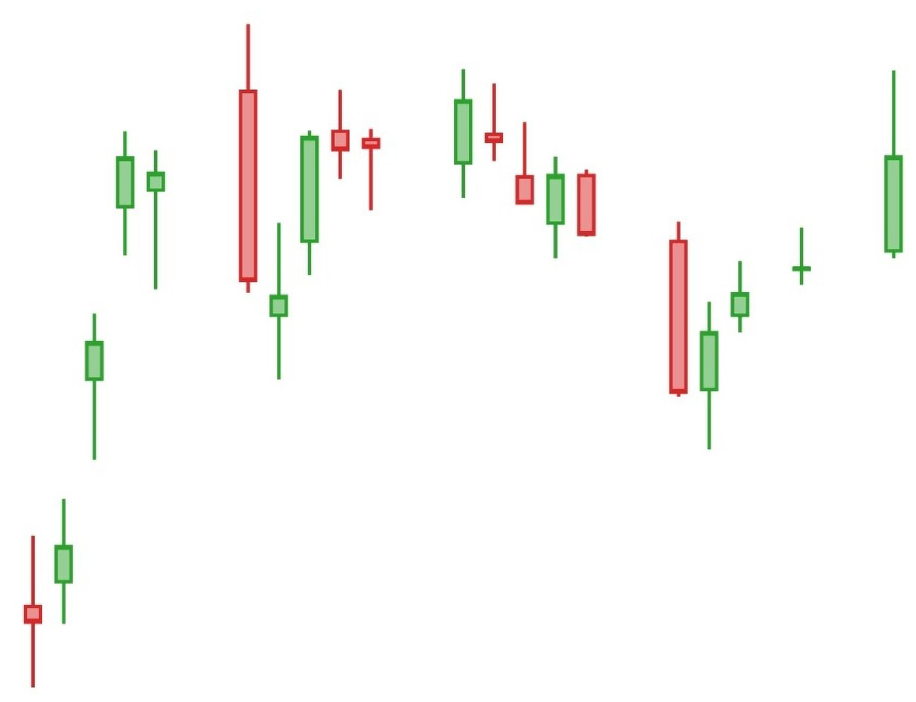
Fig 1. A 20-day candlestick